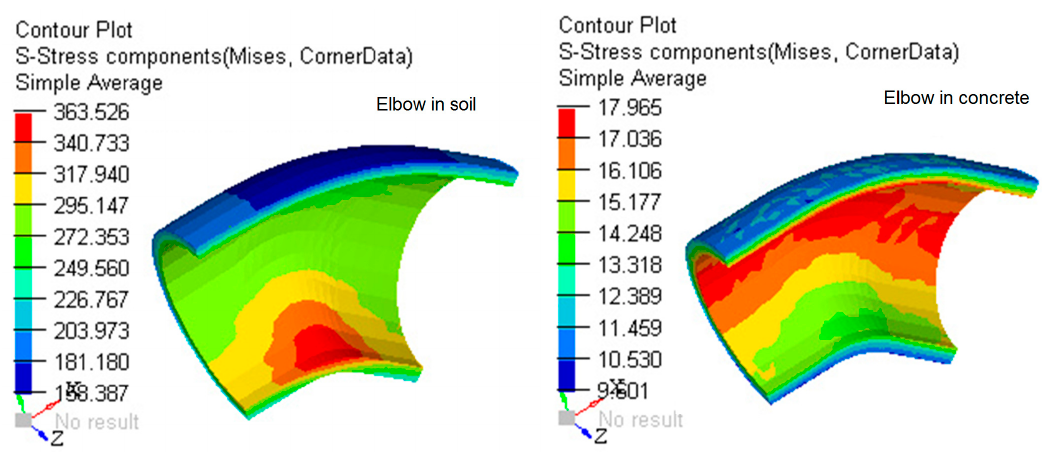
Figure 24. Stresses von Misses in elbow, in a section, in MPa (load pressure 50 MPa).